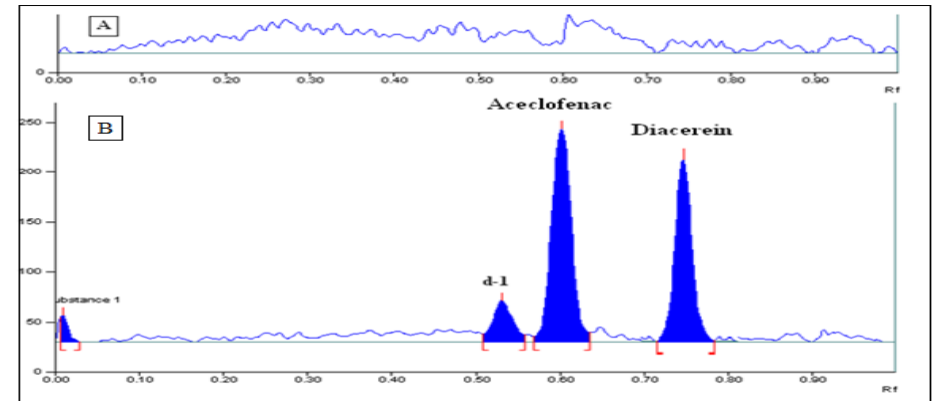
Figure 4. A- Blank H